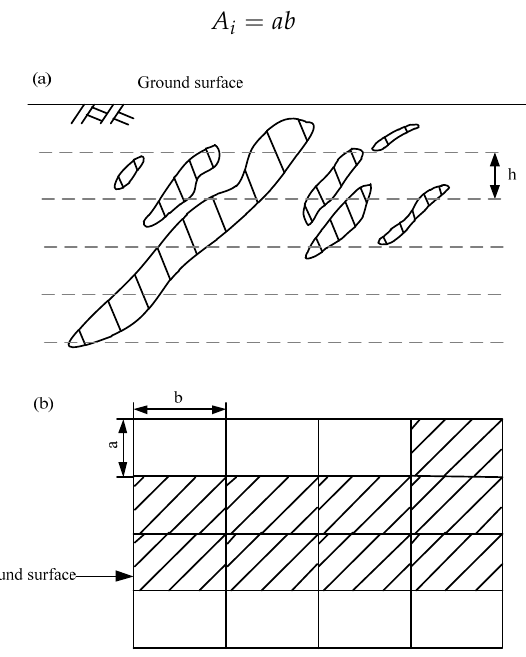
Figure 3. ( a ) Projection of karst cavern onto longitudinal section; ( b ) Projection of karst cavern onto ground surface plane (after Wang et al., 2010) [35].